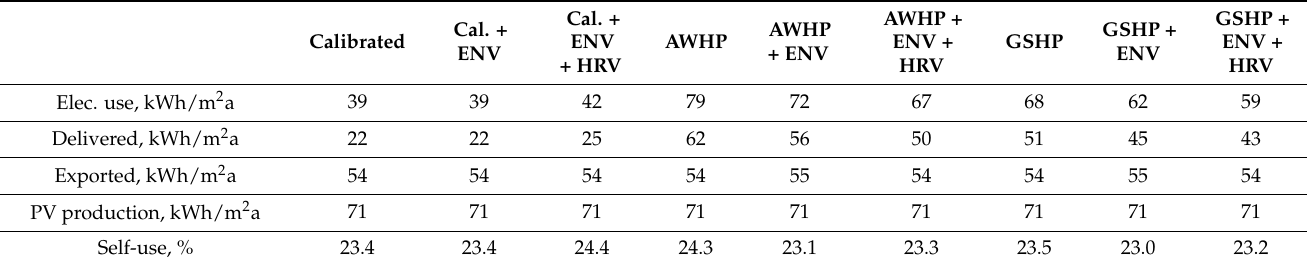
Figure 8. Yearly delivered and exported energy for a reference single-family house for different cases. Table 4. Electricity production in delivered and exported units for different cases.